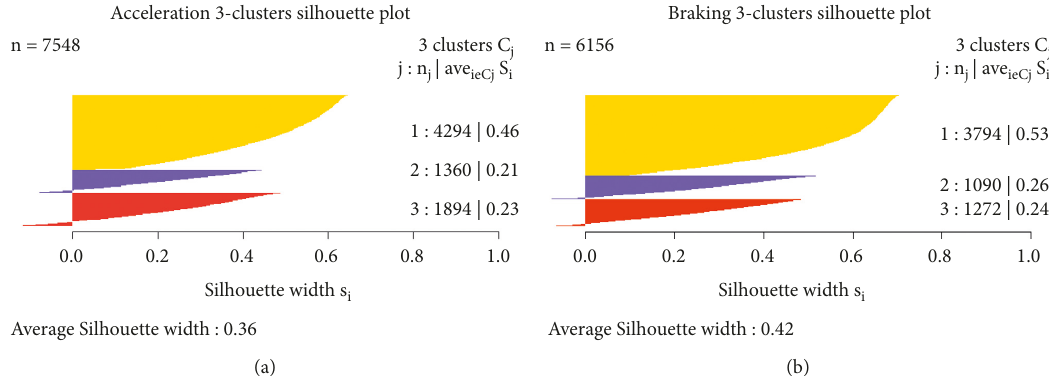
Figure 5: Silhouettes of (a) acceleration clusters and (b) braking clusters.